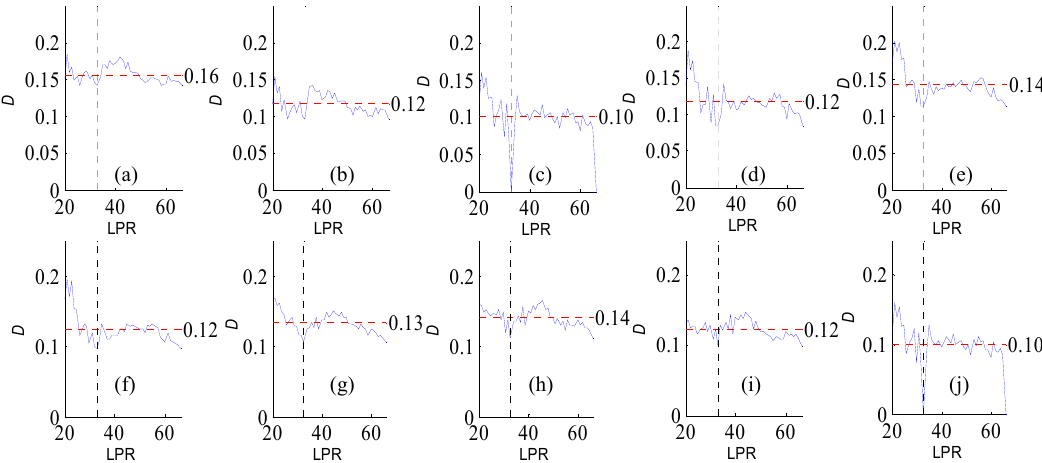
Figure A18. Variation of flow regime alteration degree (D) measured by the RVA with change in the length of post-impact flow time series (LPR) under a periodicity of 33 years. ( a – j ) correspond to pre-impact flow time series length = 24, 28, 33, 38, 42, 47, 52, 57, 61, and 66 years, respectively. The abscissa value for the vertical dotted line is 33. The ordinate value for the horizontal dotted line is the mean degree of flow regime alteration in each subfigure.